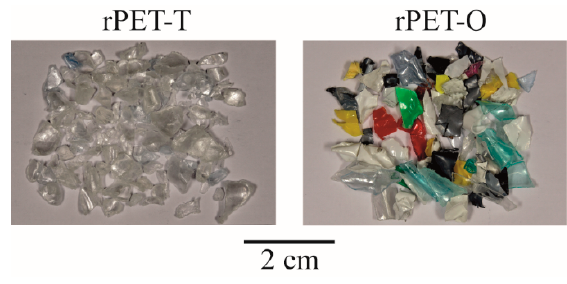
Figure 1. Post-consumer raw materials used in this study.